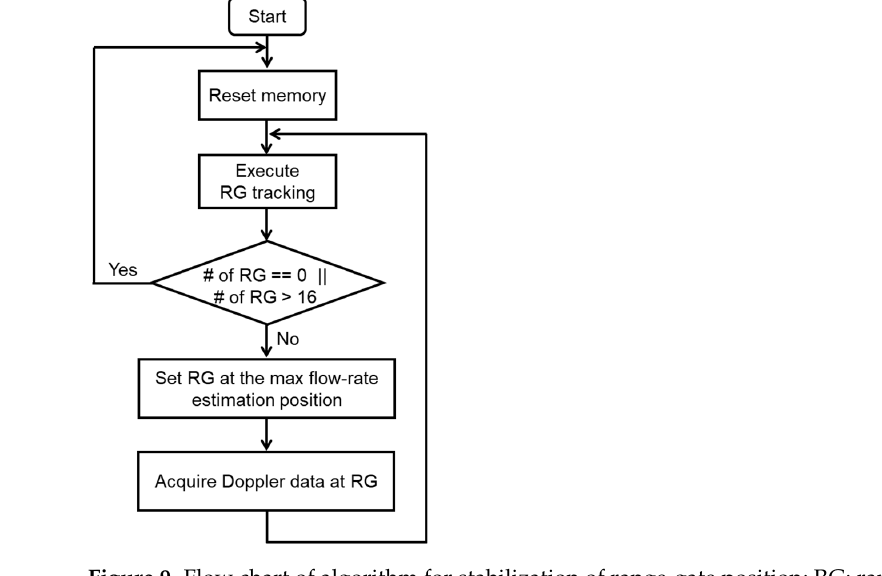
Figure 9. Flow chart of algorithm for stabilization of range-gate position; RG: range gate.